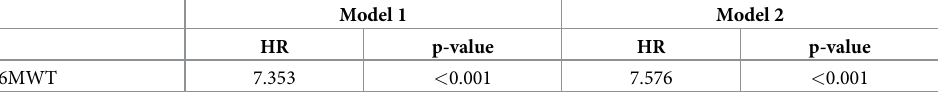
Table 5. Adjusted multivariate competing risks regression model by the presence of impairments in physical performance. Model 1 < 0.001 Data are presented as Hazard Ratios (HR). Model 1 was adjusted for age and sex; model 2 for age, sex, Davies morbidity index, and dialysis vintage. Model 1: p < 0.0001 and Chi-square = 25.7888; Model 2: p < 0.001 and Chi-